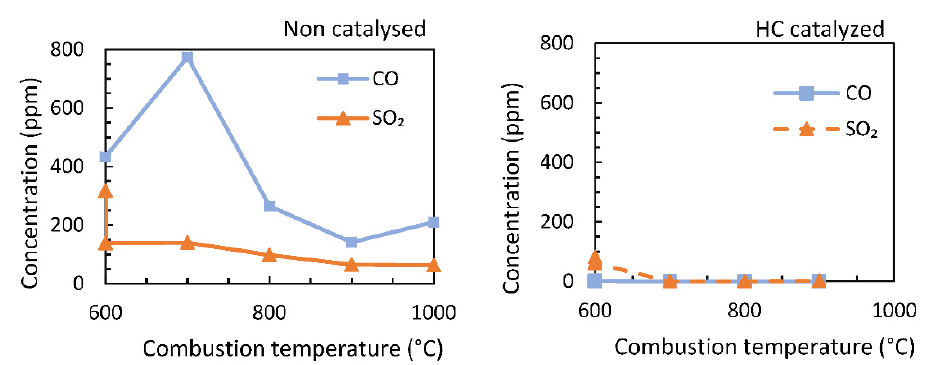
Figure 9. Comparative analysis of CO and SO 2 concentration from a catalytic and non-catalytic combustion of RB samples. Note: The catalyst was heated at optimal temperature of 427.4 ◦ C. The samples were run in triplicates.